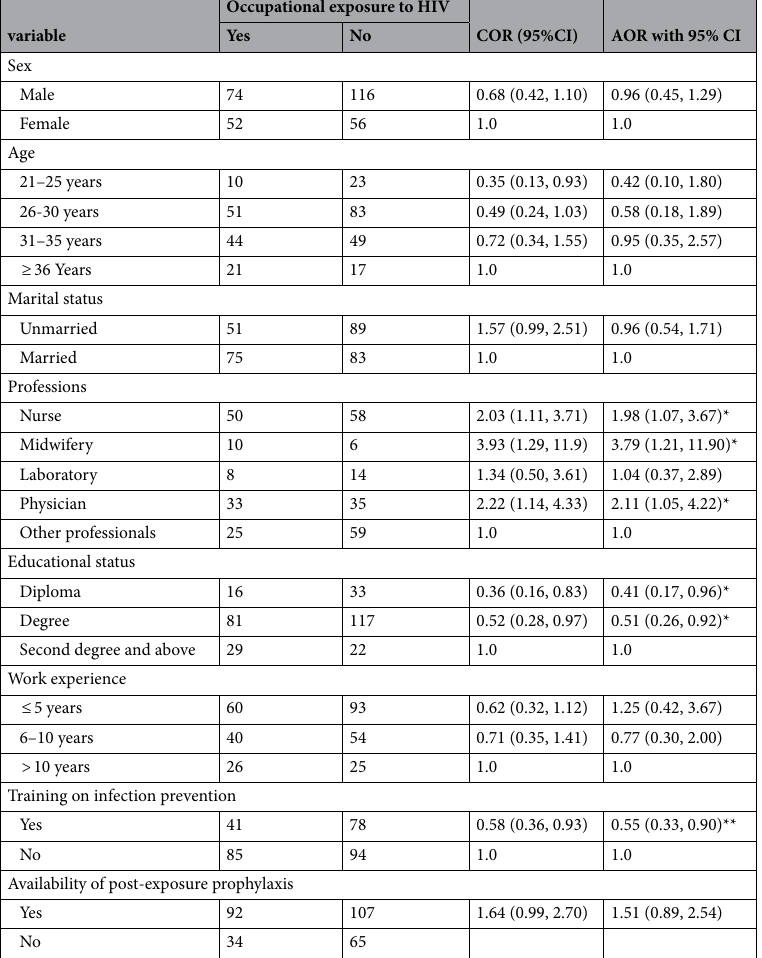
Table 4. Factors associated with occupational exposure to HIV among healthcare workers at St. Peter’s specialized hospital in Addis Ababa, Ethiopia, April 2022. *Statistically significant at p < 0.05, **statistically significant at p < 0.01. AOR adjusted odds ratio, HIV Human immunodeficiency virus, CI : Confidence interval, Hosmer and Lemeshow test = 0.147, other professional: public health officer, anesthetists, psychiatry, radiographers, pharmacy personnels, and